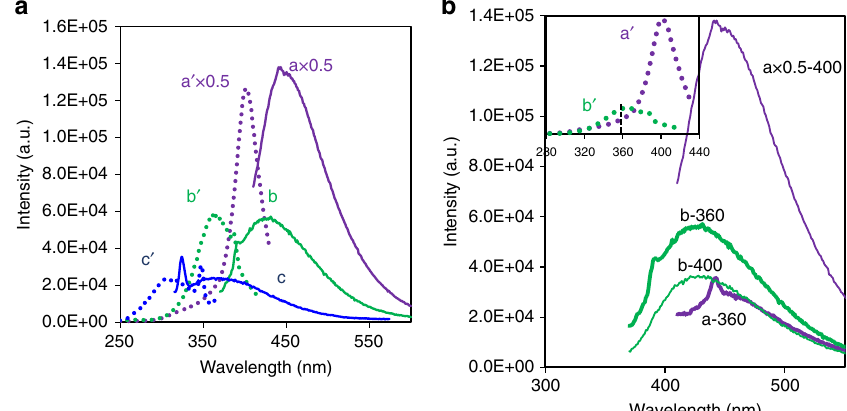
Figure 5 | Ultraviolet–visible excitation and emission spectra. ( a ) Emission (solid lines) and excitation (dotted lines) spectra of: (a,a 0 ) filtrate derived from Au/SiO 2 -A (scaled by 0.5); (b,b 0 ) 12-fold ethanol-diluted filtrate; and (c,c 0 ) 120-fold ethanol diluted filtrate. The parent filtrate contained 108ngml (cid:2) 1 of Au. Emission spectra a–c were collected using l excitation ¼ 405, 360, and 310nm, respectively. Excitation spectra a 0 –c 0 were collected by monitoring at l emission ¼ 450, 425 and, 375nm, respectively. The sharp features in spectra c,c 0 are instrument artefacts (Supplementary Fig. 15). ( b ) Emission spectra of filtrate (a) and 12-times diluted filtrate (b) collected at l excitation ¼ 400 ( (cid:2) 400 curves) and 360nm ( (cid:2) 360 curves). Inset showed the excitation spectra of the